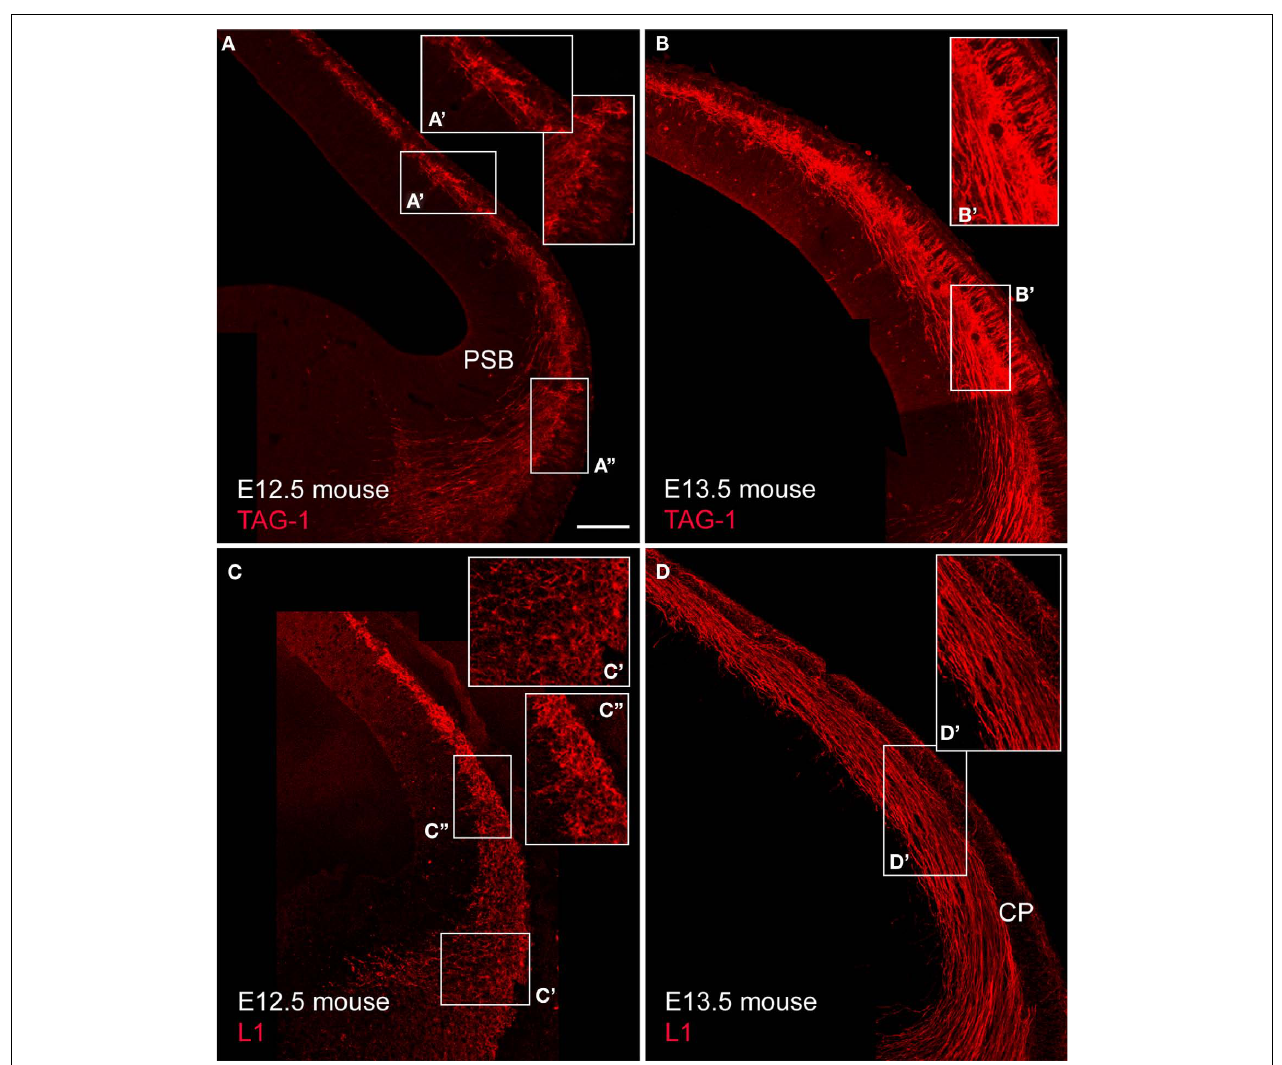
FIGURE 4 | TAG-1 + and L1 + cells in the mouse cortical primordium and their axonal projections. (A,B) show TAG-1 expression. Enlarged boxes show (A ′ ) the dorsal cortex and (A ″ ) the LP/VP territory at E12.5, and (B ′ ) the dorsal cortex at